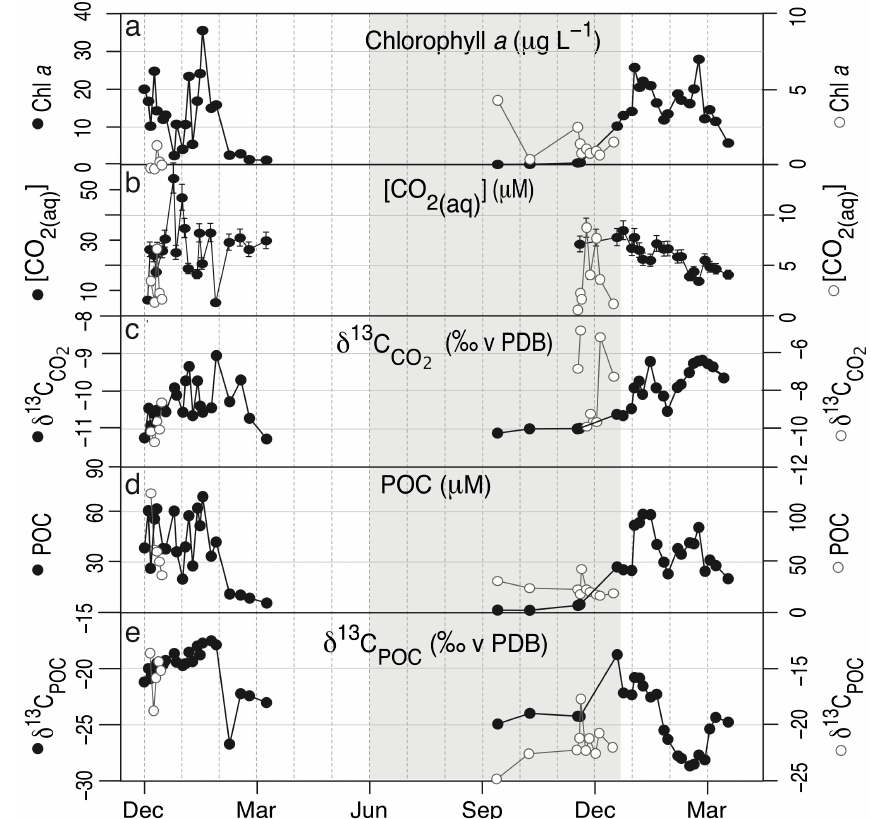
Fig. 3. Surface water (closed symbols) and sea ice (open symbols) time-series plots of (a) Chlorophyll a (b) [CO 2 (aq)] (c) δ 13 C CO and (e) δ 13 C POC between December 2004 and April 2006. Error bars on [CO 2 (aq)] depict 11% maximum error associated with calculation using the CO2SYS programme. Note different scales for sea ice (right hand y-axis) and surface water (left hand y-axis). The period of full sea ice cover is indicated by grey shading. All water samples are from 15m